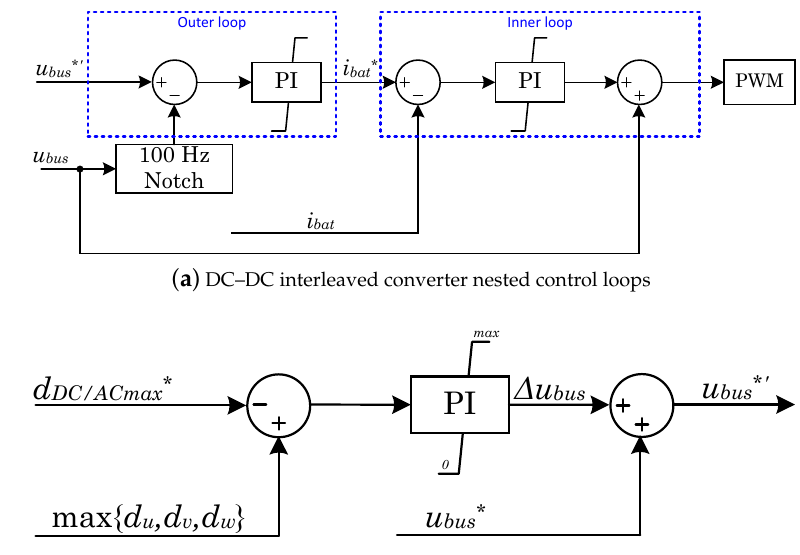
Figure 3. Interleaved DC–DC converter control schemes. Proportional Integral